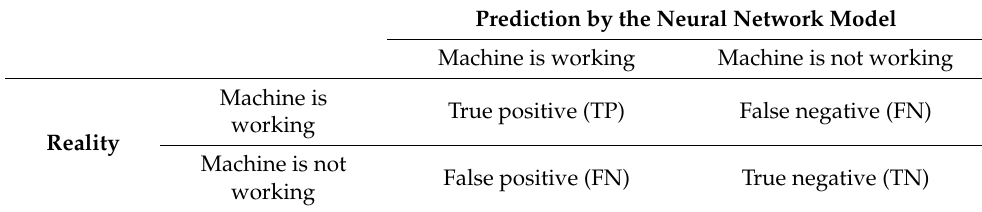
Figure 7. The error norm of the ANN learning of sensor (b) in Table 1. Table 2. The confusion matrix for the machine utilization abstracting neural network.